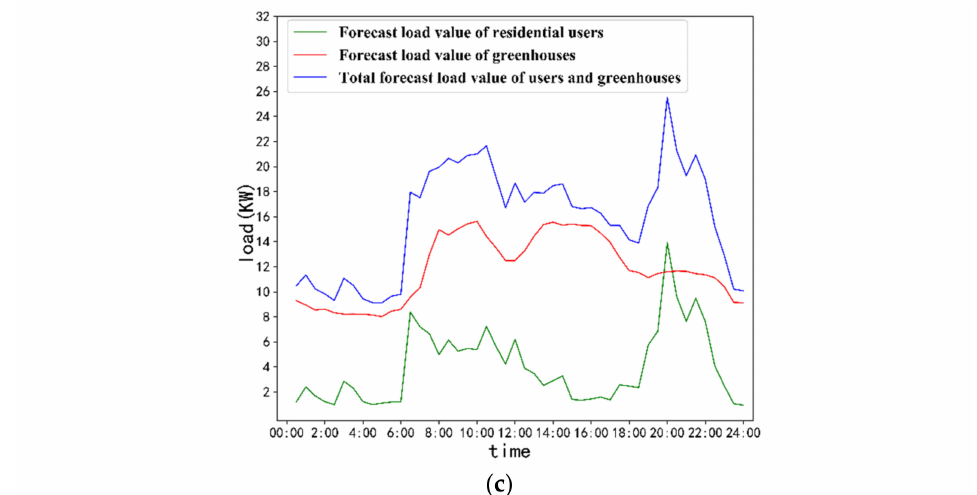
Figure 8. Load forecasting results of rural microgrid: ( a ) residential load forecasting result; ( b ) agricultural load forecasting result; ( c ) total load forecasting result.